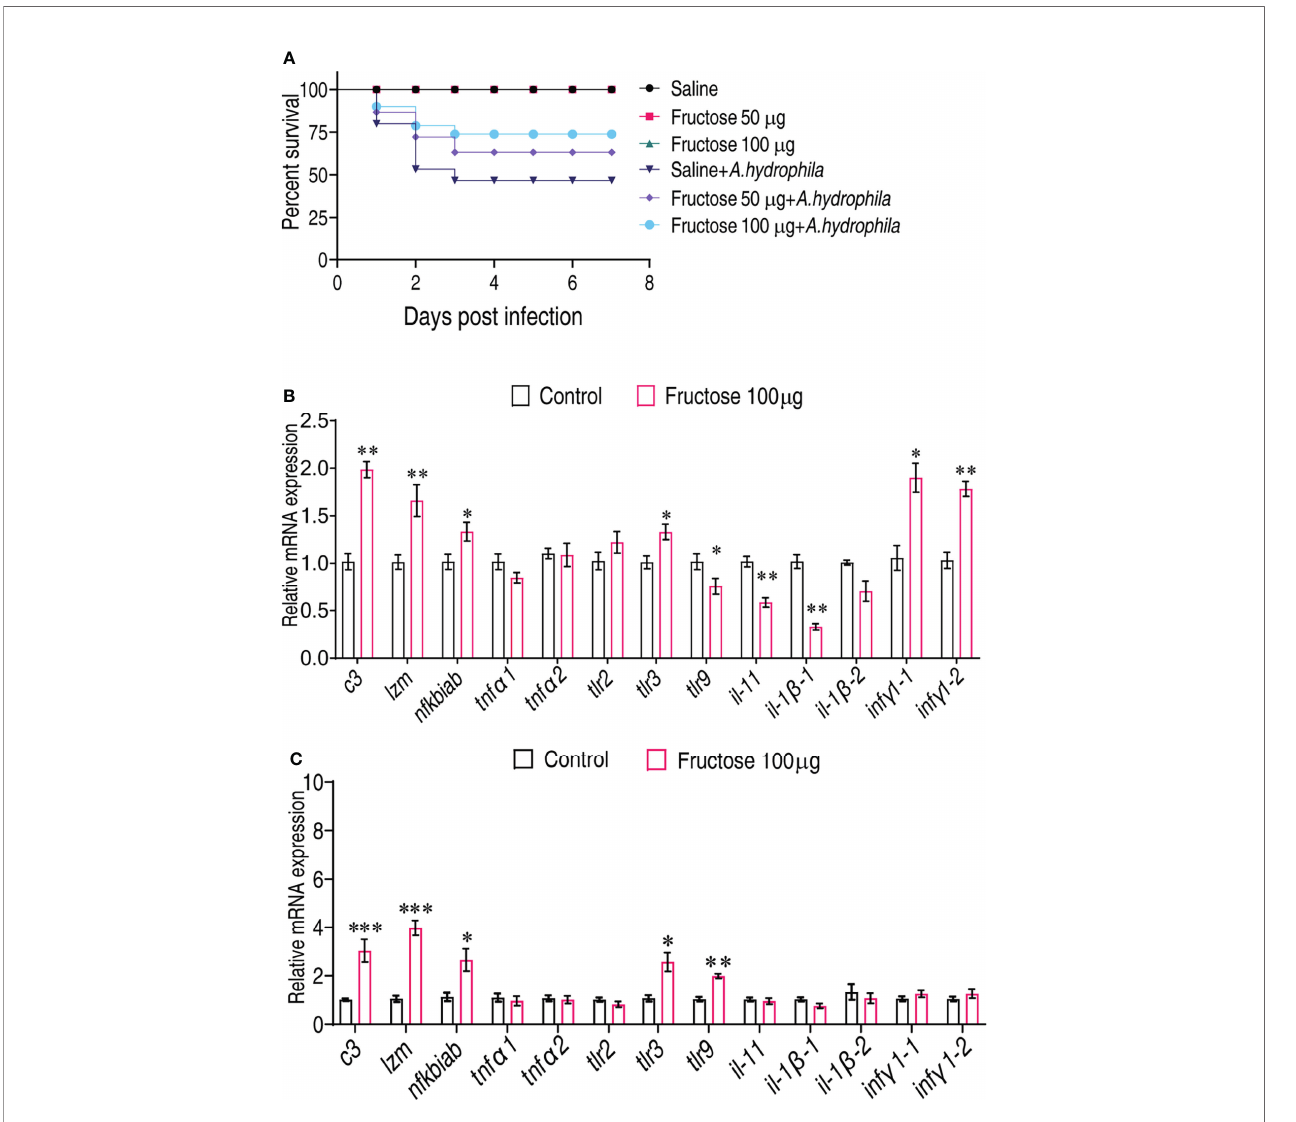
FIGURE 4 | Fructose promote crucian carp survival by modulating immune response. (A) Percent survival of crucian carp challenged with A . hydrophila in the presence or absence of the indicated dose of fructose. (B) qRT-PCR for cytokine expression of crucian carp treated with saline or fructose (100 m g) for 3 days. (C) qRT-PCR for cytokine genes of crucian carp treated with saline or fructose (100 m g) for 3 days followed by infection with a non-lethal dose of A . hydrophila. Values are means ± SEM from six biological replicates and signi fi cance was analyzed by the Mann – Whitney U-test. *p < 0.05, **p < 0.01, ***p < 0.001.